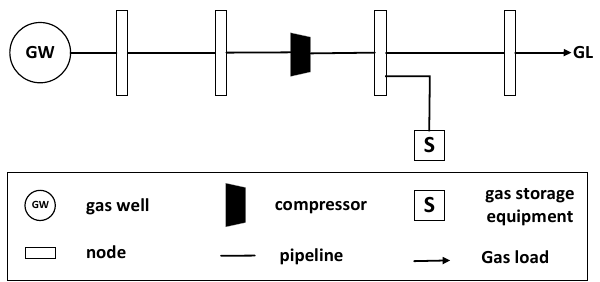
Figure 2. Natural gas system. In the figure, “GW” is the abbreviation of gas well, which means the source of natural gas production; ”GL” is the abbreviation of gas load, which means the load of the natural gas system; ”S” is the abbreviation of gas storage equipment, which means the storage equipment of the natural gas system; the white rectangles represent the nodes in the natural gas system; the black line represents the pipeline in the natural gas system; the black trapezoid represents the compressor in the natural gas system.